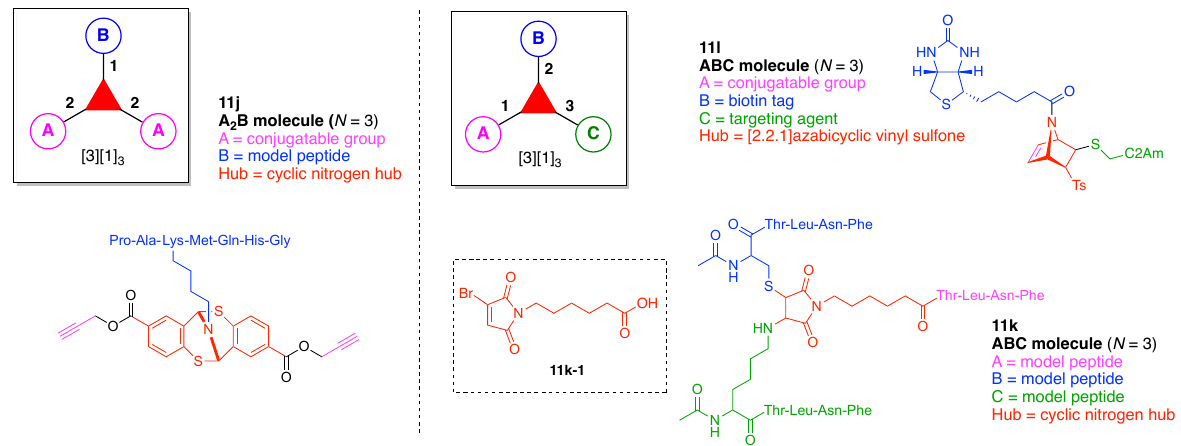
Figure 57. Examples wherein each contains a single nitrogen hub.